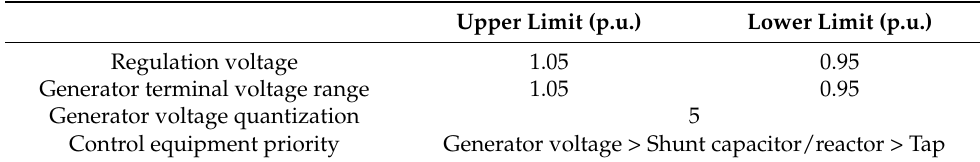
Table 1. Operation conditions for voltage